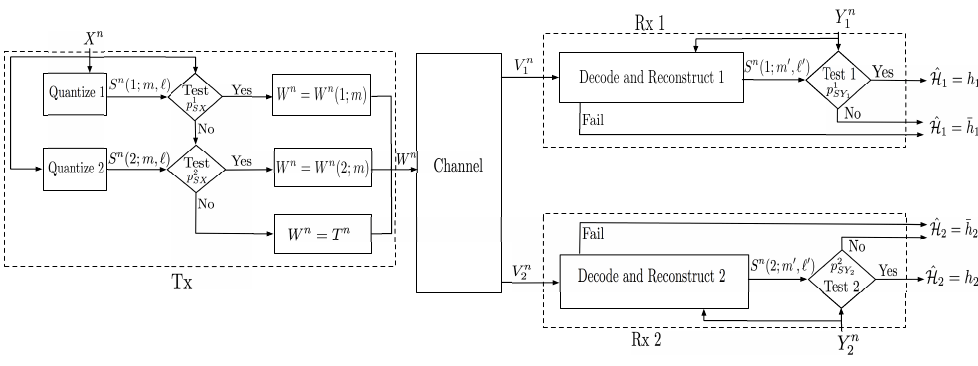
Figure 3. Coding and testing scheme for hypothesis testing over a BC.